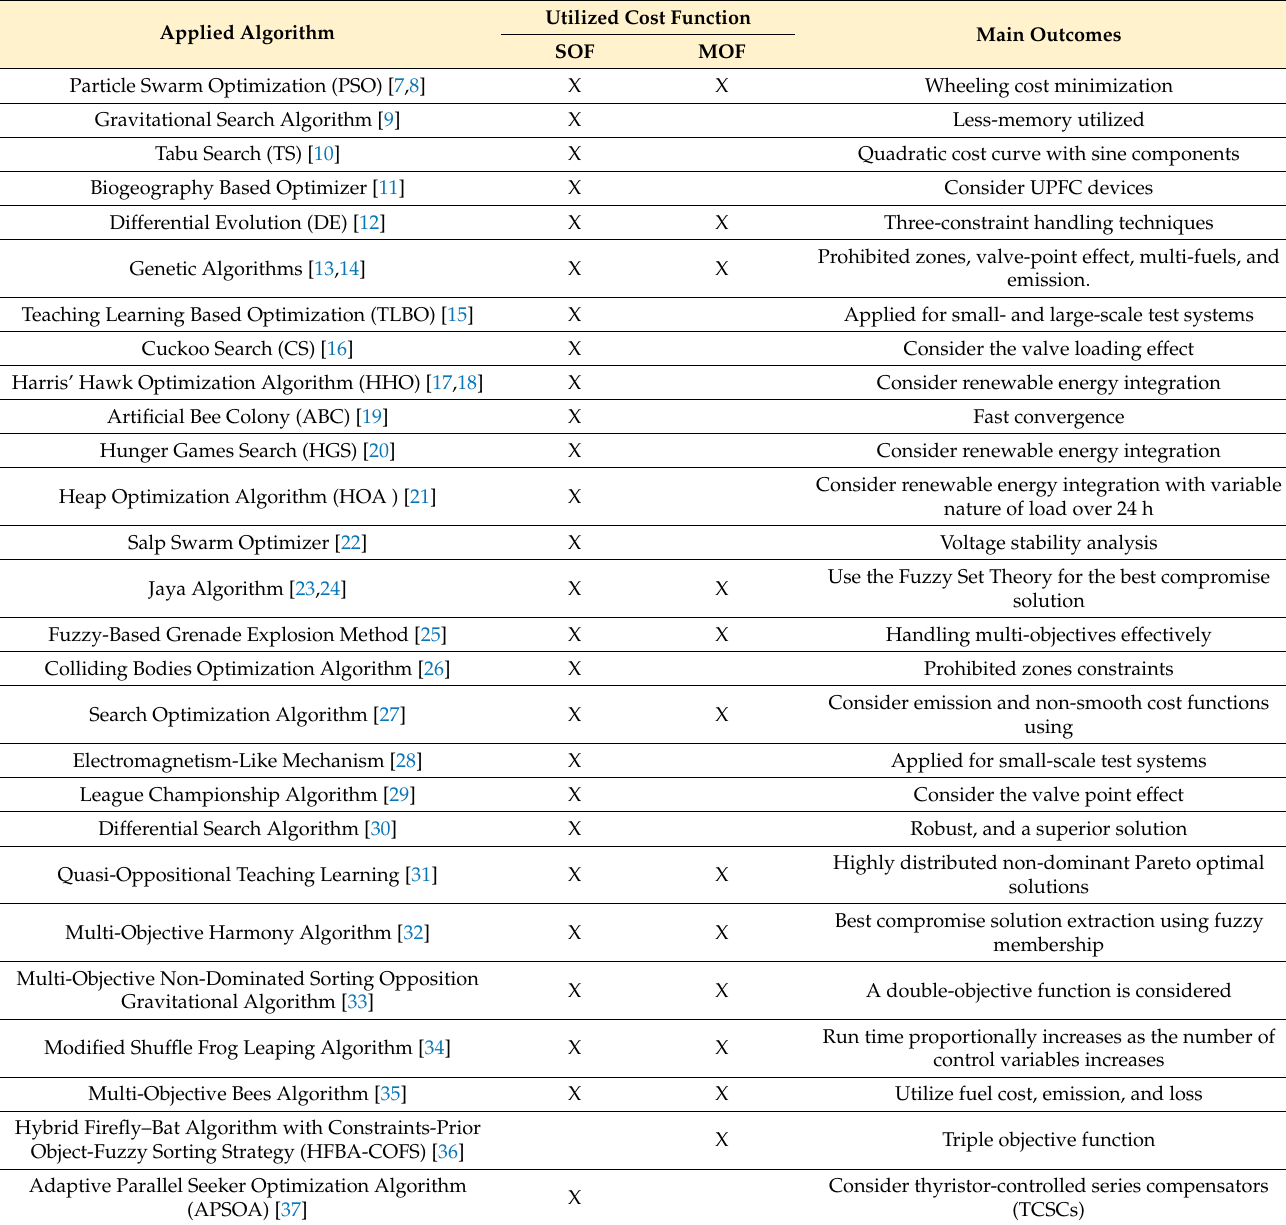
Table 1. Reported OPF meta-heuristic algorithms in the